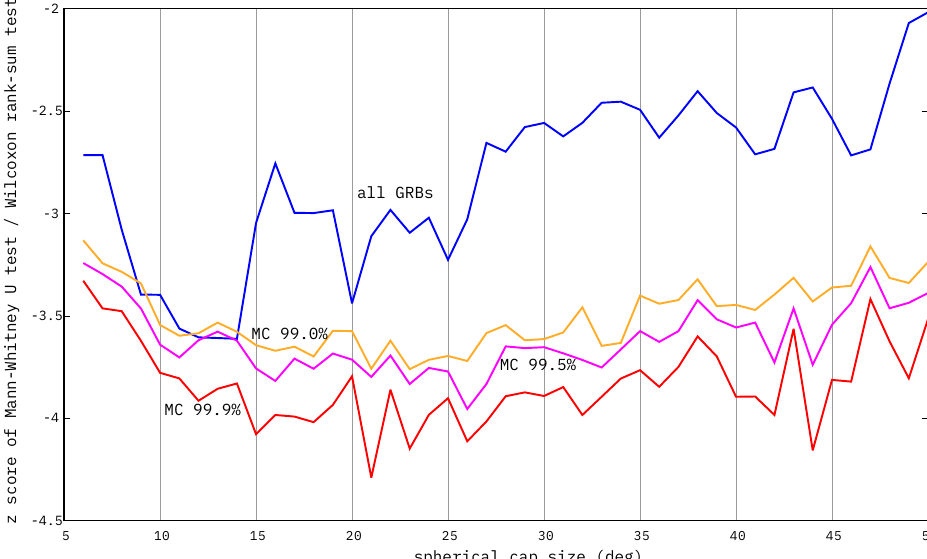
Figure 5. Mann-Whitney U-test’s Z scores of the real data’s lowest values (blue) and the 99%, 99.5%, and 99.9% values of the Monte Carlo simulations. The real data’s second smallest Z scores are greater than the 99% curve of the Monte Carlo simulations, therefore are not shown for clarity. One should observe the 12–14 ◦ region with a random probability of ≈ 1%.